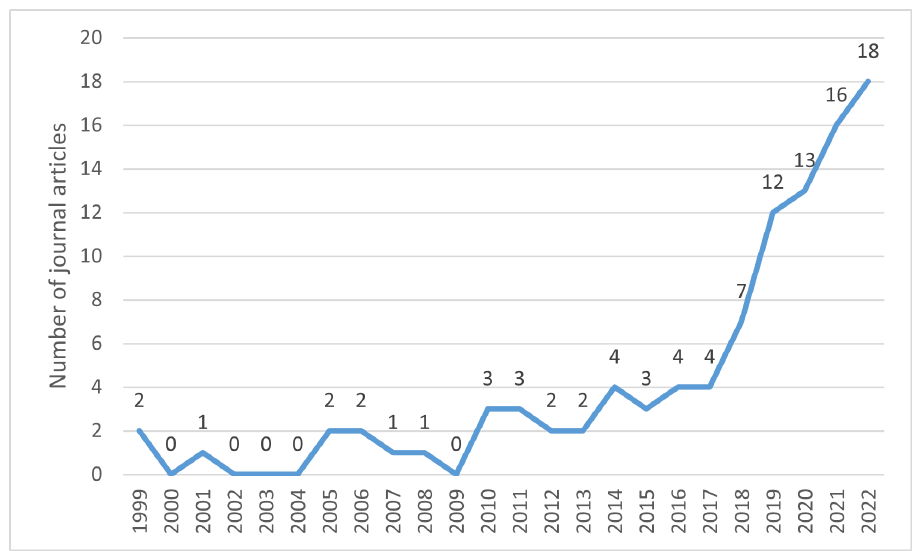
Figure 1. Annual distribution of the journal articles about MADM methods in AM. From the perspective of the journals where the articles were published, the top five journals that have published the most research articles about MADM methods in AM include, as shown in Figure 2, Rapid Prototyping Journal (ISSN: 1355-2546), The Inter- national Journal of Advanced Manufacturing Technology (ISSN: 0268-3768), Materials Today: Proceedings (ISSN: 2214-7853), Robotics and Computer-Integrated Manufacturing (ISSN: 0736-5845), and Procedia CIRP (ISSN: 2212-8271). It can also be seen from the figure that the Rapid Prototyping Journal and The International Journal of Advanced Manufactur- ing Technology published a total of thirty-one articles, accounting for 31% of the articles included in the statistic.